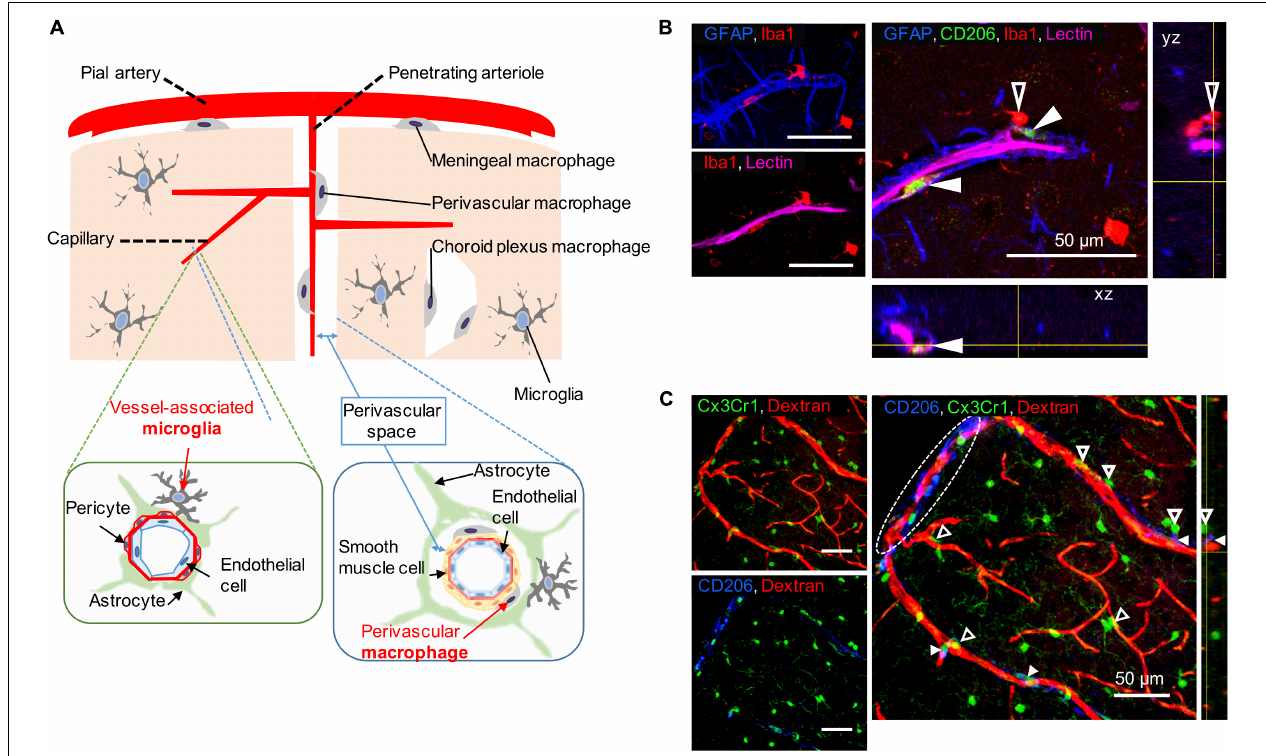
FIGURE 1 | Vessel-associated microglia and perivascular macrophages (PVMs) in their workplace. (A) Scheme illustrating the differential location of CNS-macrophages including perivascular macrophages (PVMs), parenchymal microglia, and vessel-associated microglia (VAM) around the cerebral small vessels. Representative cortical areas in rat (B) and mice (C) imaged by confocal microscopy after immunostaining to reveal the presence and location of PVM (filled arrow heads) and VAM (empty arrow heads) using a set of different markers. (B) Two CD206-positive PVMs (green) are located between astrocyte end-feet (GFAP, blue) and endothelial cells stained by the injection of lectin. The PVM shows a flattened shape and a low-intensity Iba1 staining compared to VAM that are located beyond the glia limitans. The location of the x , z view (bottom) and the y , z view (right) corresponds to yellow lines. (C) Elongated CD206-positive PVMs (blue) are located along a large penetrating arteriole and pia artery (in white dotted circle) stained by the injection of 70-kDa dextran-Texas Red in a transgenic Cx3Cr1 gfp / wt mouse. VAM show a high Cx3Cr1 expression (green) compared to PVMs. The location of the y , z view (right) corresponds to yellow